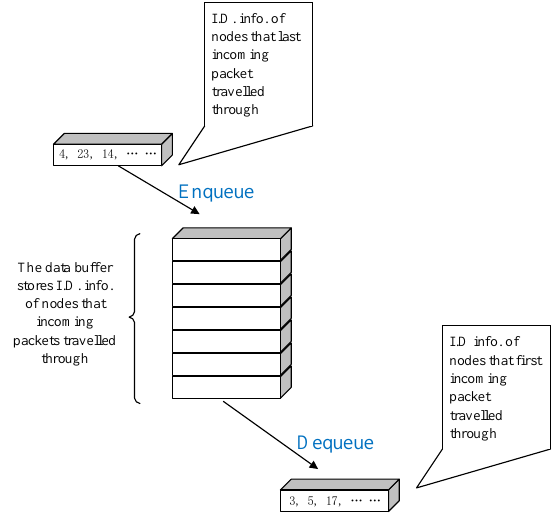
Figure 3. Format of data